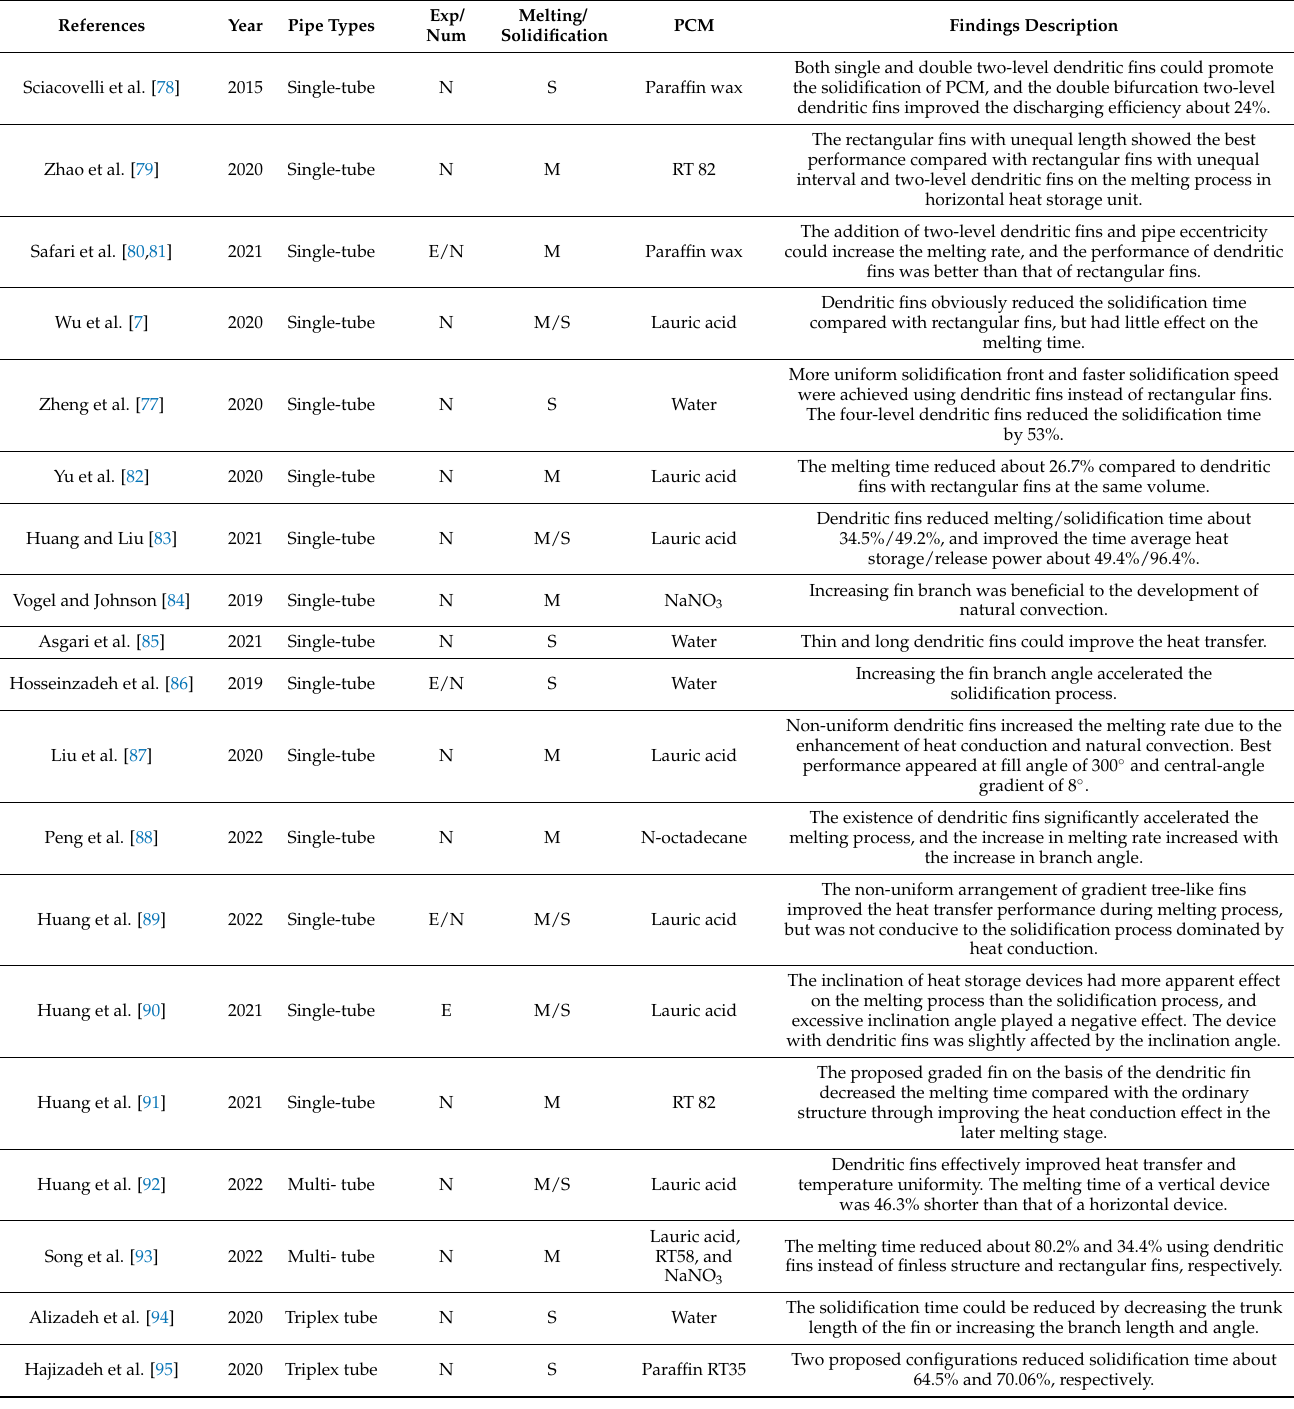
Table 3. Applications of dendritic fins in LHTES